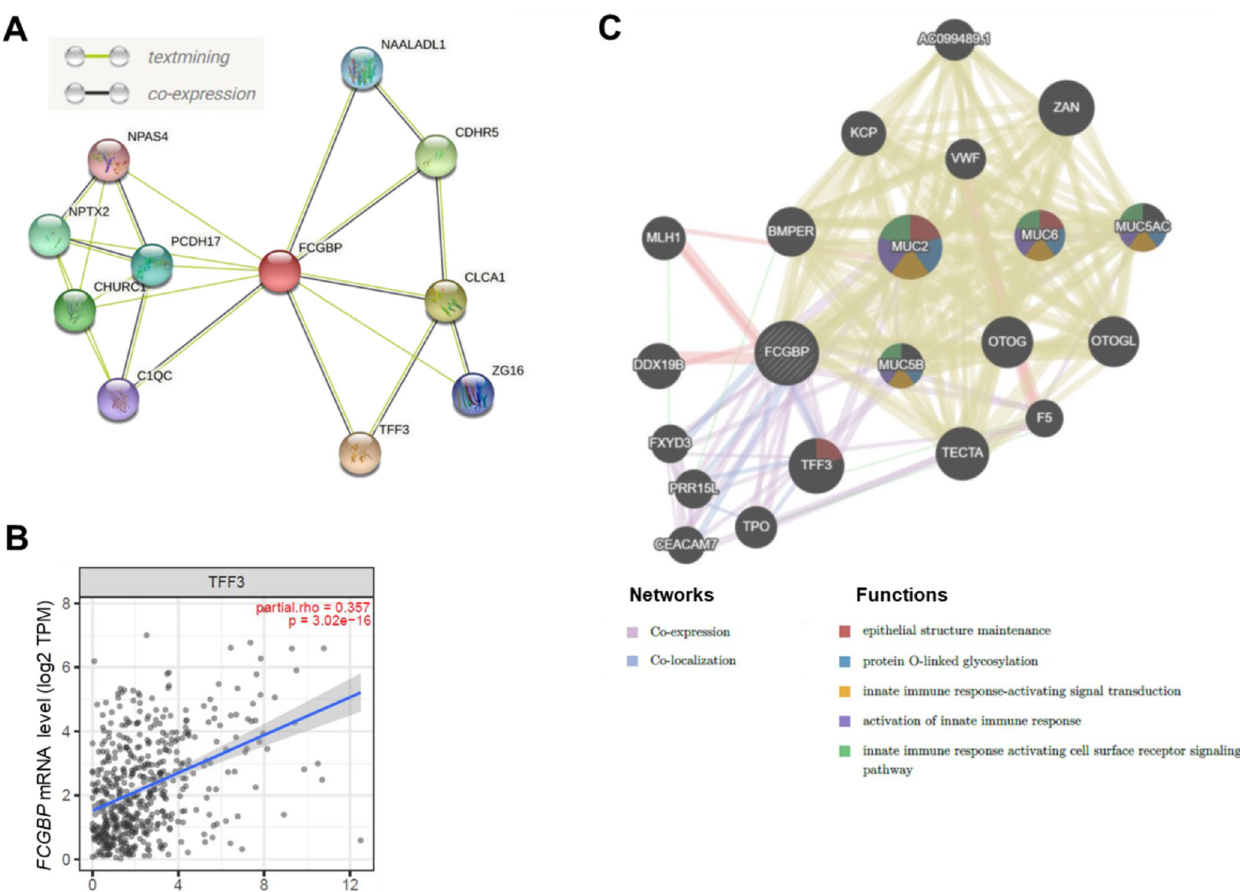
Figure 4. The FCGBP interacted gene/protein networks. ( A ) The STRING database showed the FCGBP interacted gene/protein network based on text mining and co-expression. ( B ) TIMER2.0 identified a potential interaction between FCGBP and TTF3 based on co-expression in HNSC pa- tients ( n = 522; partial r = 0.357, correlation adjusted by purity; p < 0.001). ( C ) The GeneMania database showed the gene-gene interaction network. The association between FCGBP and TFF3 based on co-expression and co-localization highlighted the genes with function enriched in epithelial structure